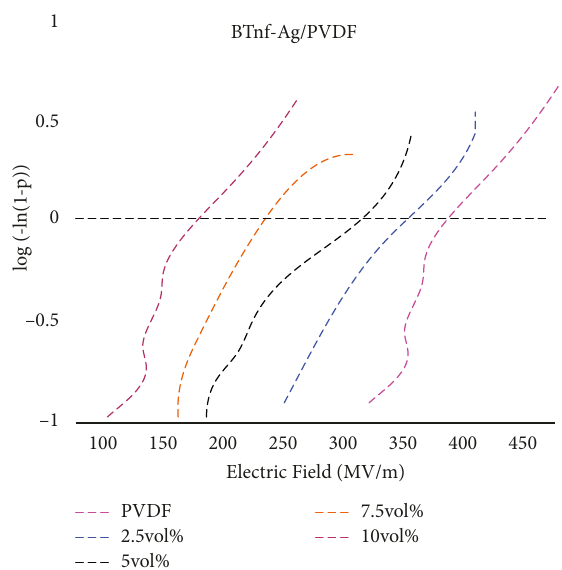
Figure 7: Weibull DC breakdown strength of the BTnf-Ag/PVDF